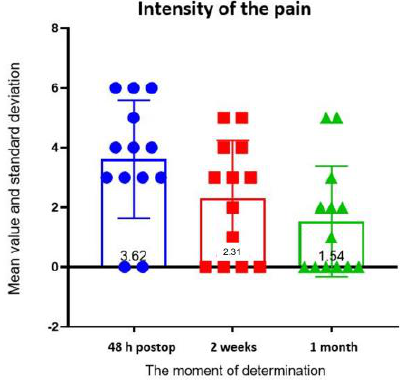
Figure 11. Pain intensity assessment.